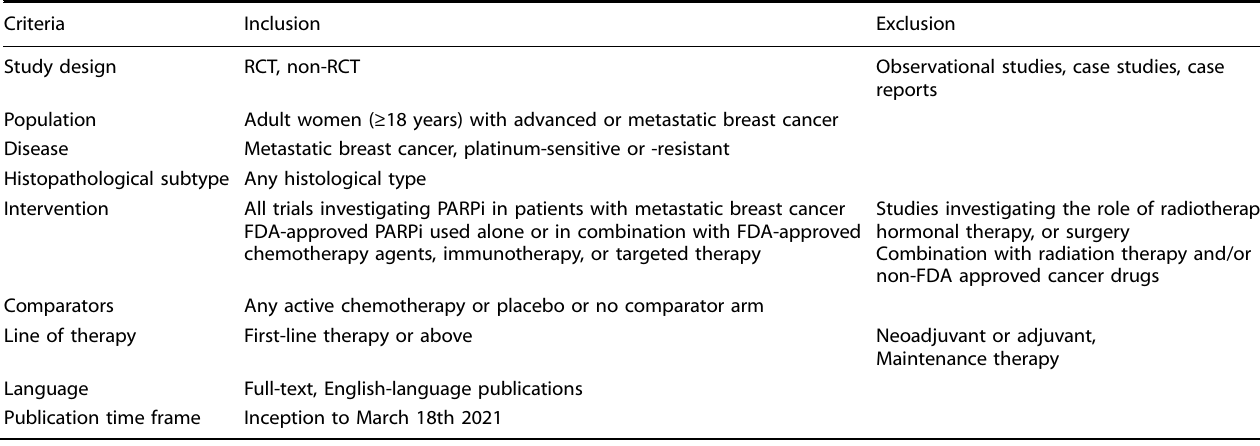
Table 4. Inclusion/Exclusion criteria for